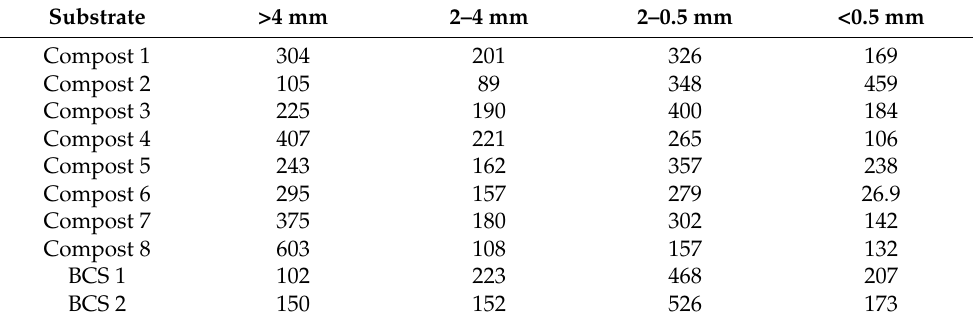
Table 1. Weight proportions (g kg − 1 ) from the particle size classes (psc’s) of the